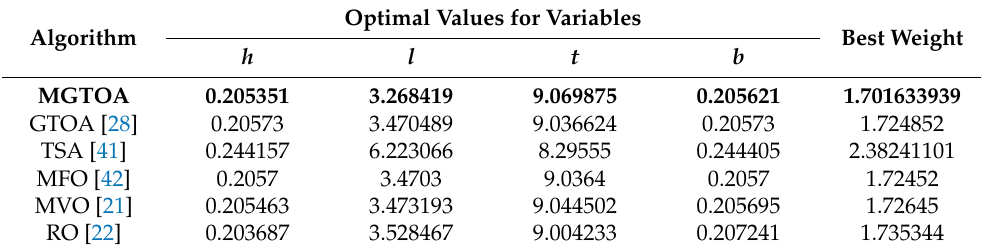
Table 10. Experimental results of Welded Beam Design.